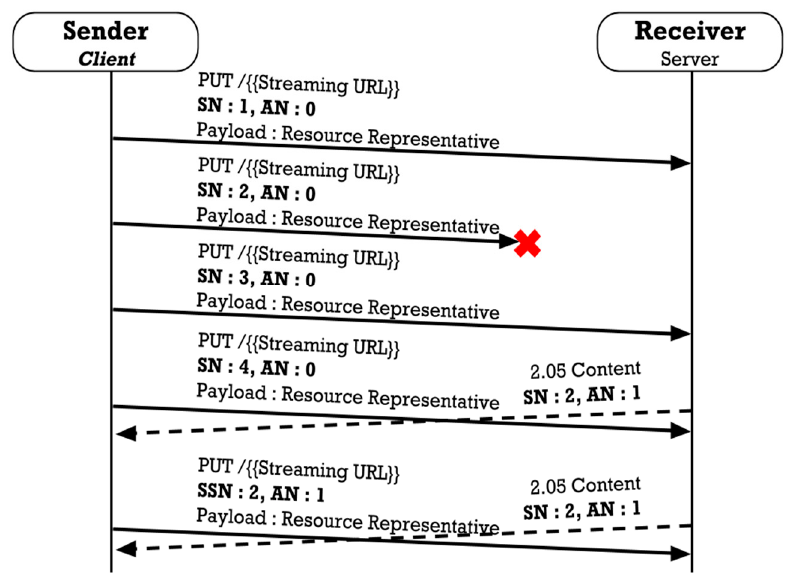
Figure 11. Example of error handling operations for CoAP-SC.